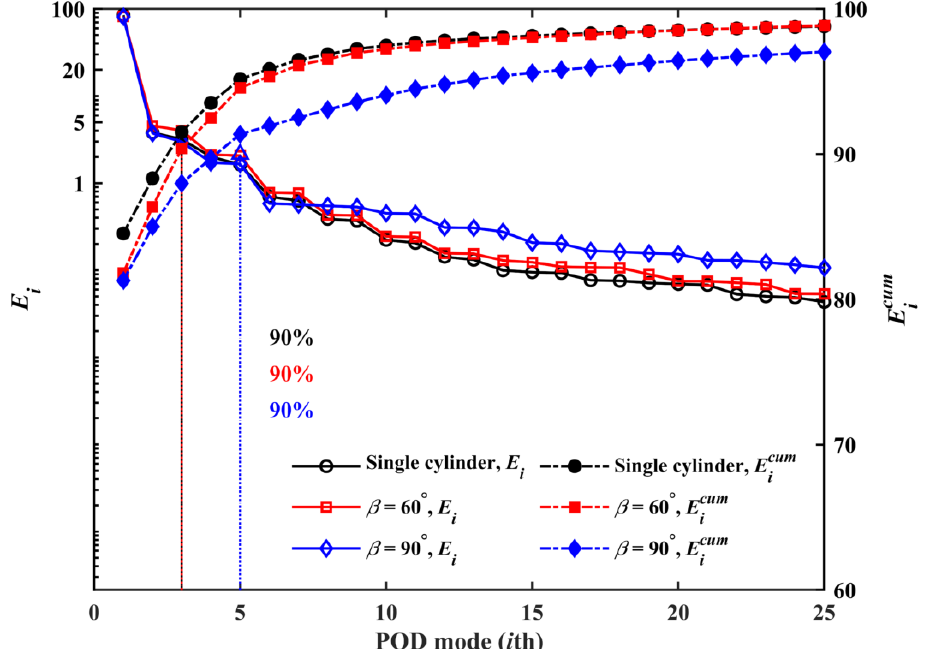
Figure 12. Relative and cumulative energy of the POD modes.